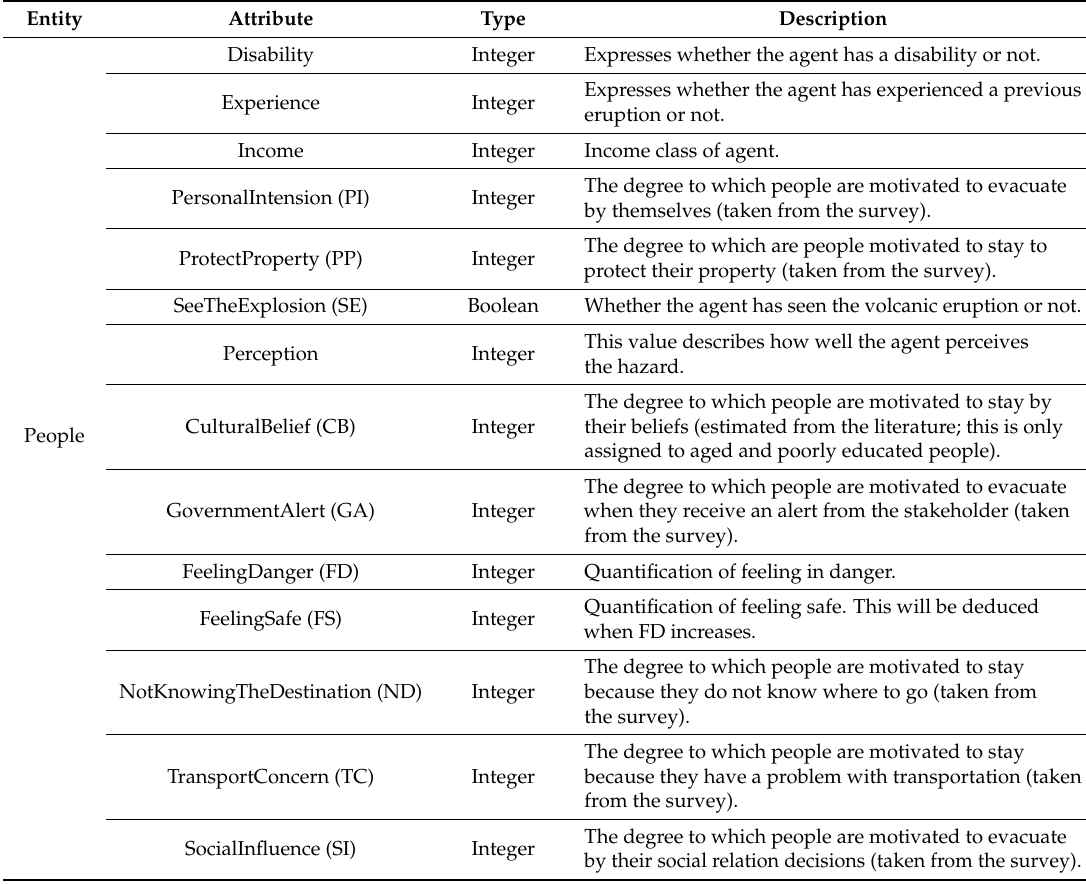
Table 2. Overview of main attributes additional to the previous model